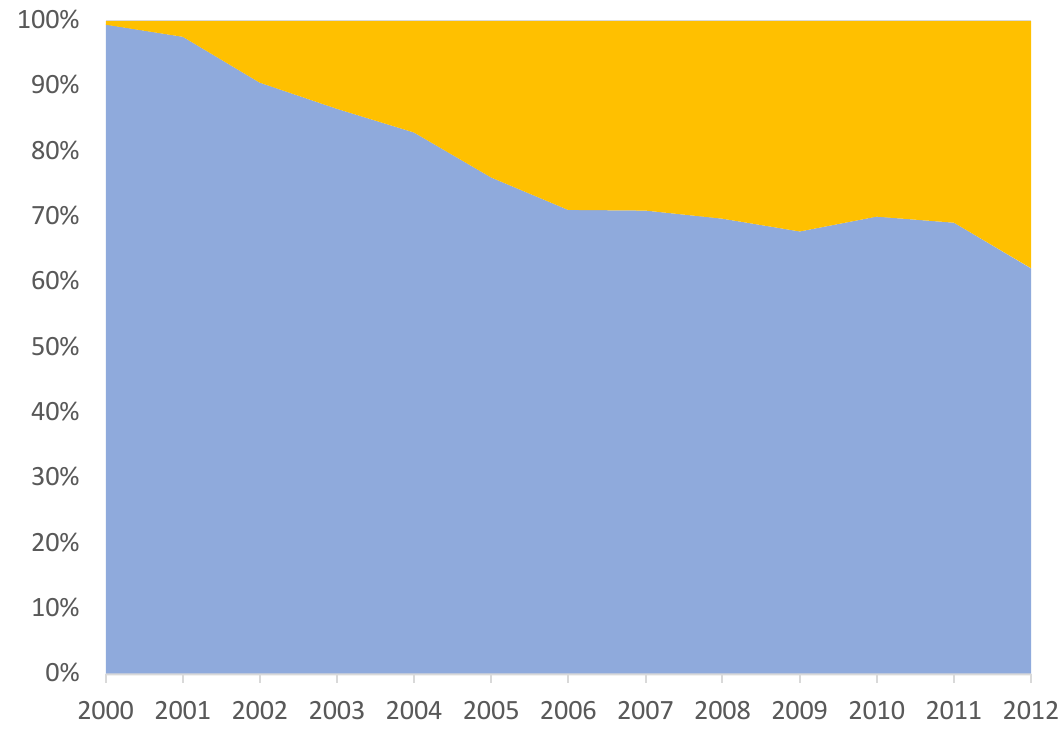
Figure 1: Share of ESI enrollees who face a choice of multiple health insurance plans with uneven levels of financial risk. Notes: Data source: commercial claims data set. Choice employers are defined as those who offer at least one low-deductible plan, and one high-deductible plan. Thresholds for low- and high-deductible levels are based on the IRS’s cutoffs for health savings account